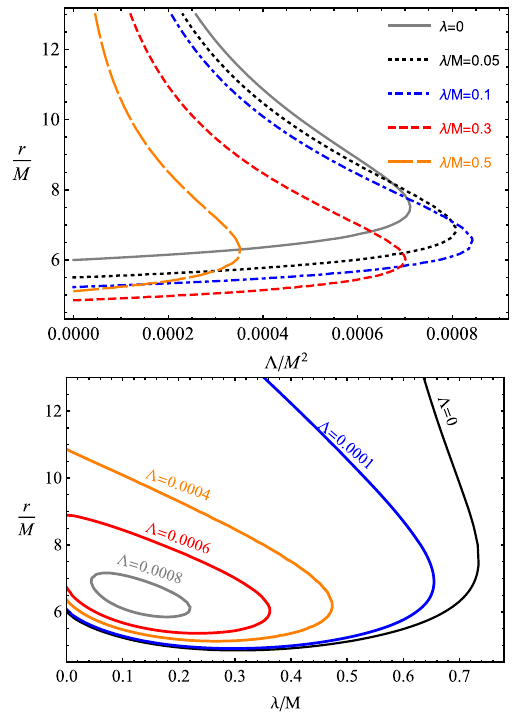
Fig. 3 Dependence of ISCO and OSCO radius as a function of the cosmological parameter Λ in top panel (PFDM parameter λ in bottom panel)fordifferentvaluesofPFDMparameter(cosmologicalconstant). The lower (upper) part of the curve determines the ISCO (OSCO). In this plot we use Λ → Λ/ M 2